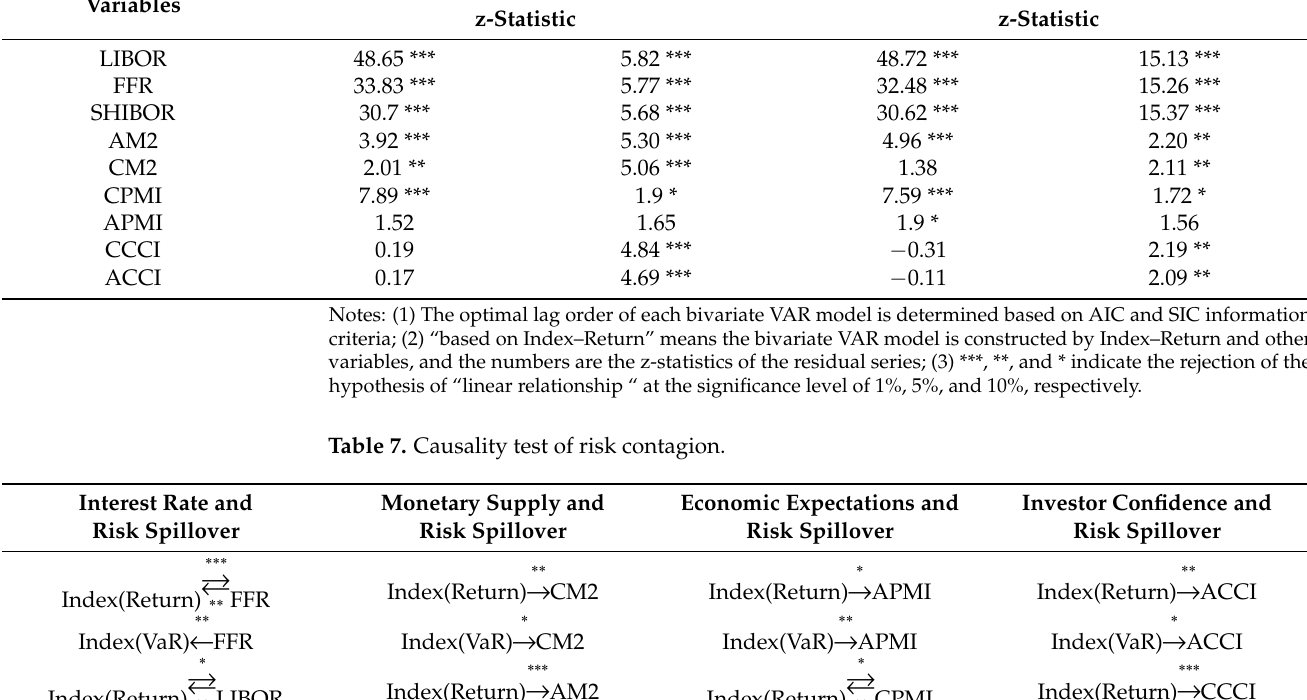
Table 7. Causality test of risk contagion.